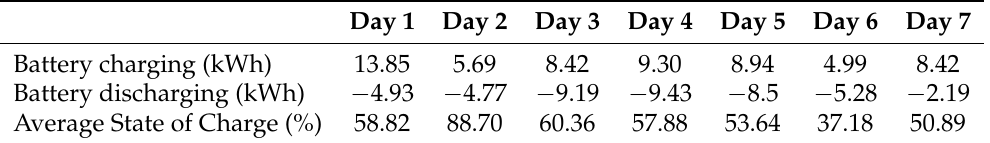
Table 5. Battery charging, battery discharging, and state of charge for every day of the week after applying the